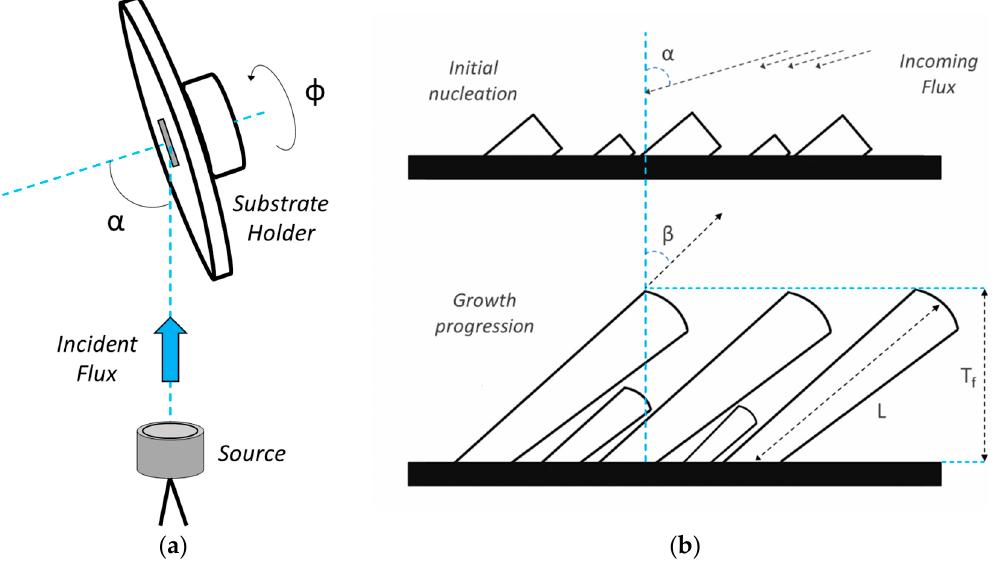
Figure 1. ( a ) Glancing angle deposition (GLAD) configuration showing incident flux angle, α , and rotation angle, φ , around the substrate normal. ( b ) Growth of nanocolumns with GLAD in Volmer–Weber growth mode illustrating growth progression, incident flux angle, α , column tilt angle, β , column length, L , and overall film thickness, T f .